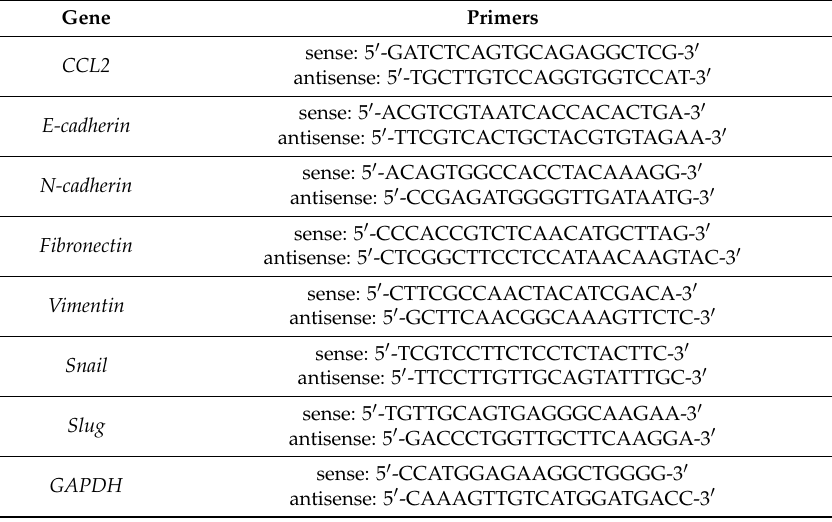
Table 1. The gene-specific primers used in this